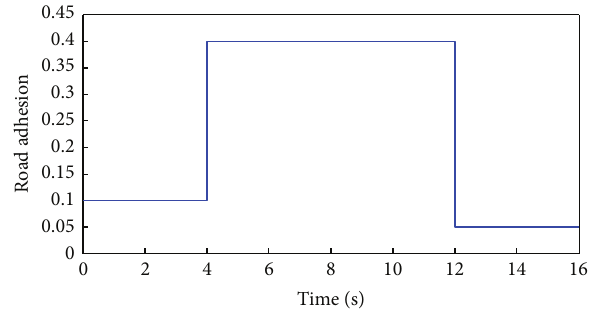
Figure 19: Adhesion coefficients of road surfaces.